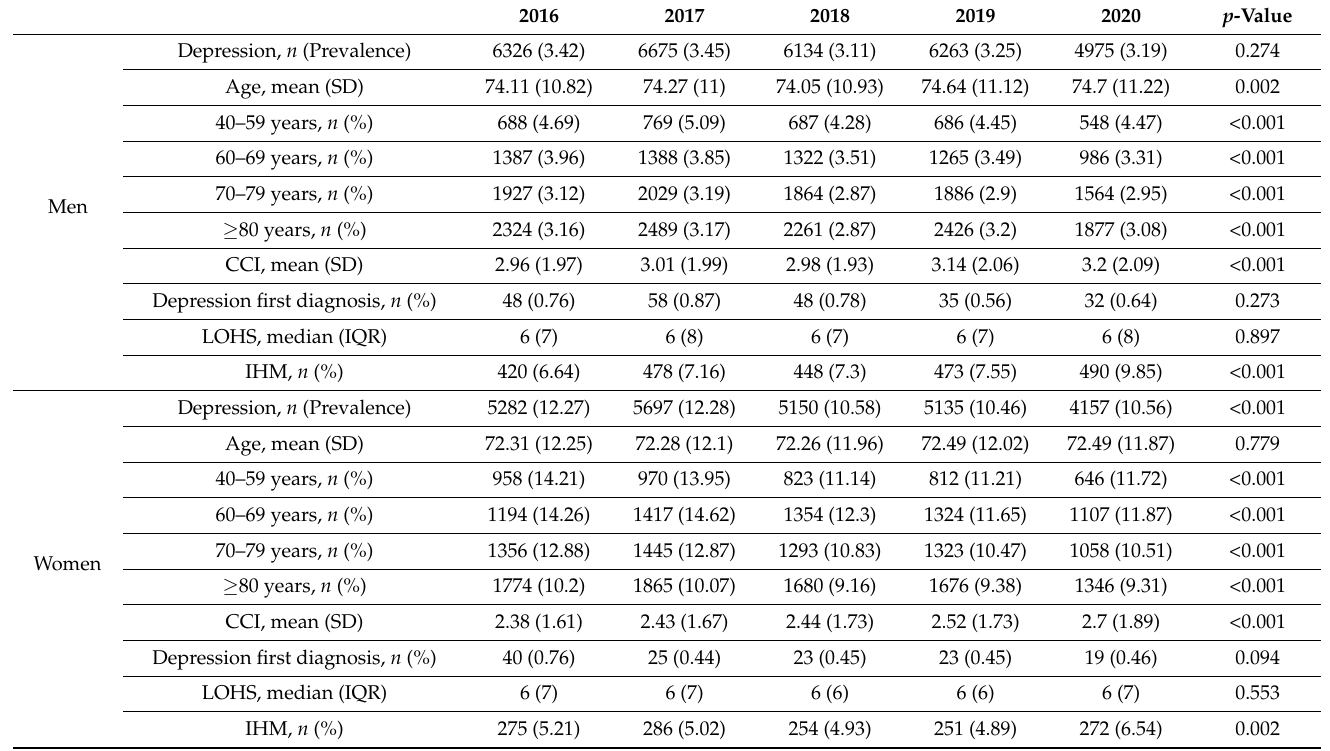
Table 2. Prevalence of depression, age distribution, clinical characteristics and in-hospital outcomes among hospitalized men and women with COPD in Spain